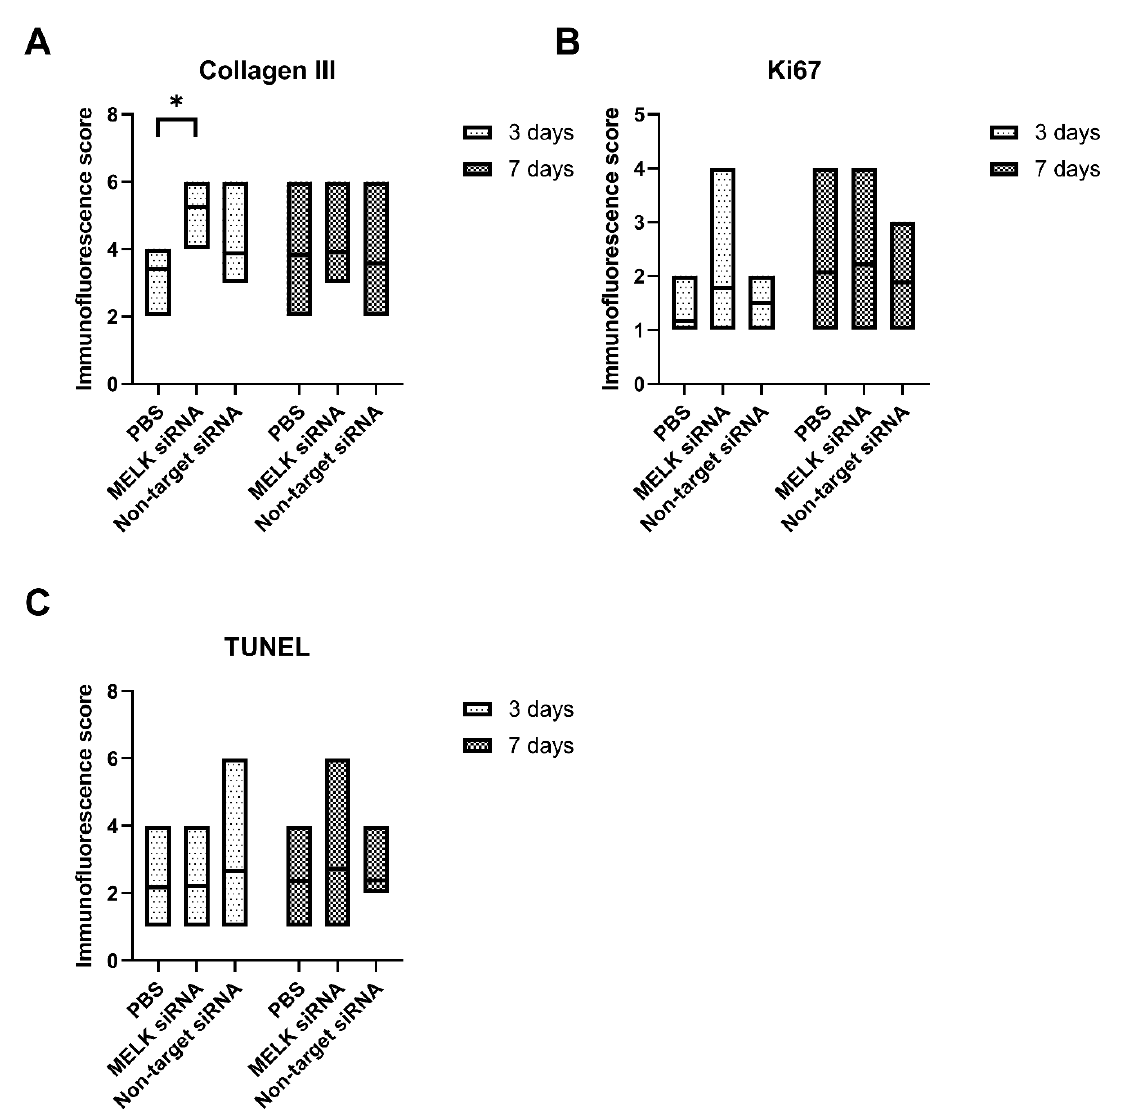
Figure 5. Immunofluorescence staining results of wounds 3 and 7 days after treatment with PBS, MELK siRNA, and non-target. ( A ) Expression of Collagen III. ( B ) Proliferation activity analysis measured as immunofluorescence score of Ki67. ( C ) Apoptosis analysis measured as immunofluorescence score of TUNEL staining. n ≥ 6. Results are presented as the mean ± range. * — p < 0.05